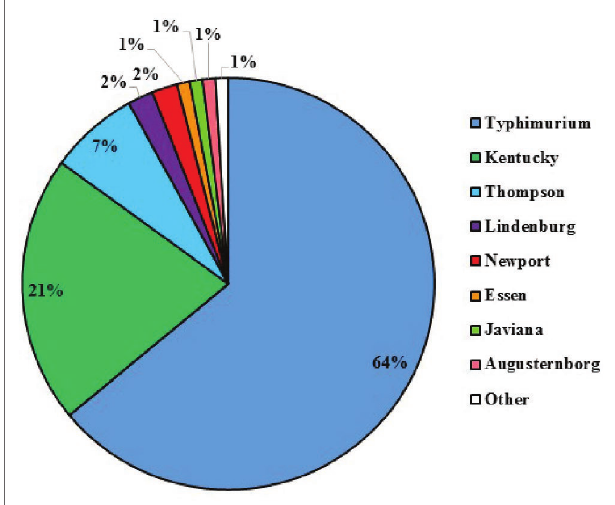
FIGURE 5 | Serovar diversity of total identified S. enterica isolated from poultry litter samples collected from all three tested commercial broiler Farms 1–3 on the ESV ( n = 210).